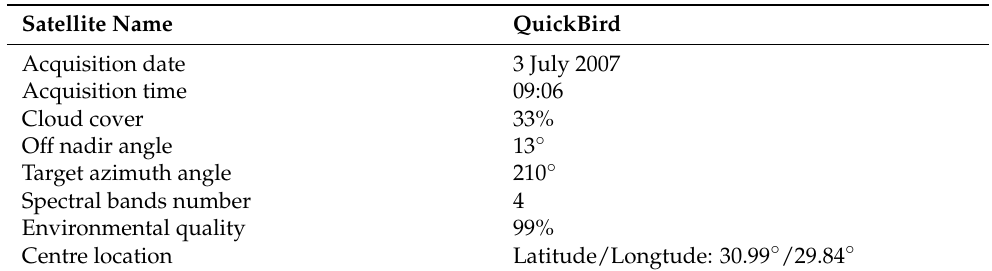
Table 1. Technical characteristics of QuickBird image of wheat fields captured on 7 March 2007 in South-West Nile Delta,